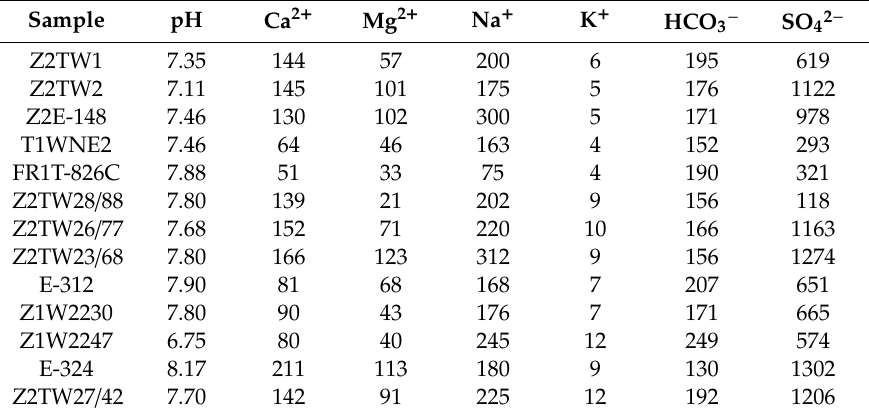
Table 1. Chemical composition of ground water